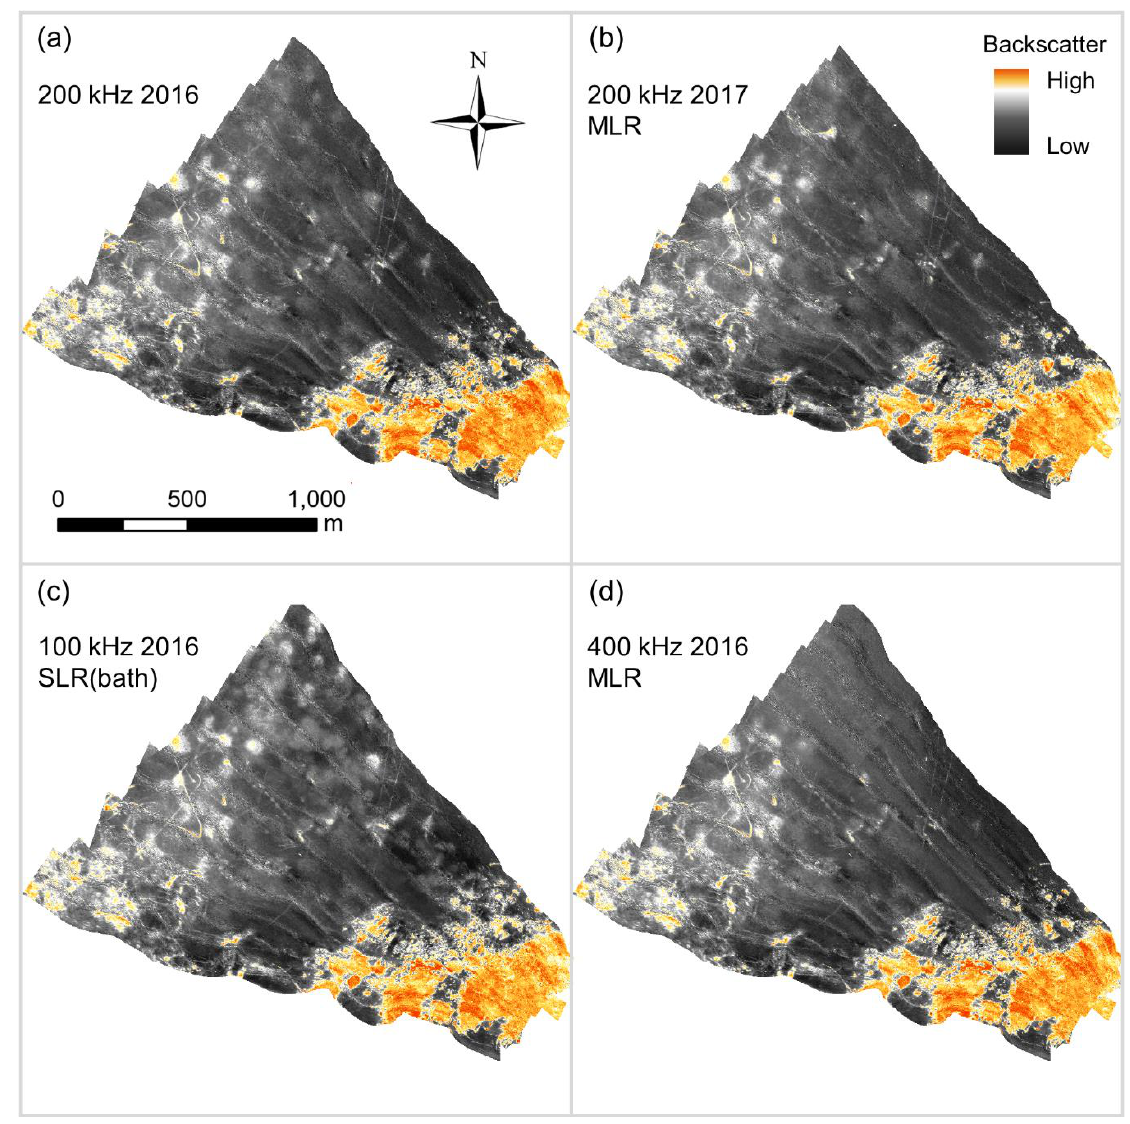
Figure A3. Highest quality bulk shift mosaics of ( a ) the 2016 Bedford Basin 200 kHz dataset, with ( b ) 2017 200 kHz, ( c ) 2016 100 kHz, and ( d ) 2016 400 kHz datasets.